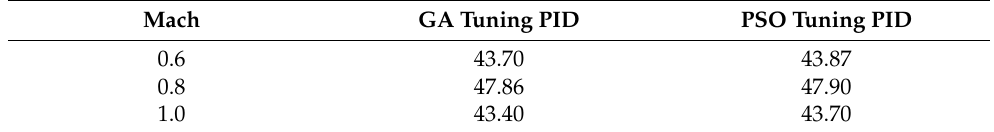
Table 4. Optimal error function